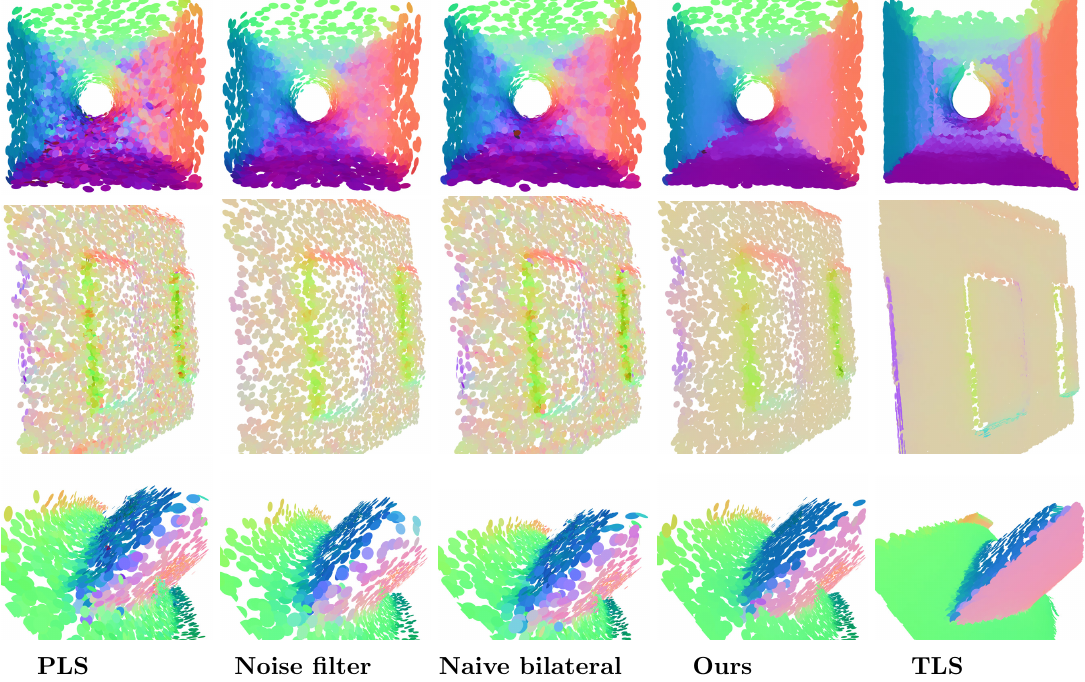
Figure 6. Noise attenuation using CloudCompare (v.2.11, 2021) noise filter, naive application of the bilateral filter, and our method, compared to TLS data. Points are colored by their normals. Top: A column base (interior view); Middle: projecting and recessed brickwork wall pattern; Bottom: Tip fo a sharp pointed